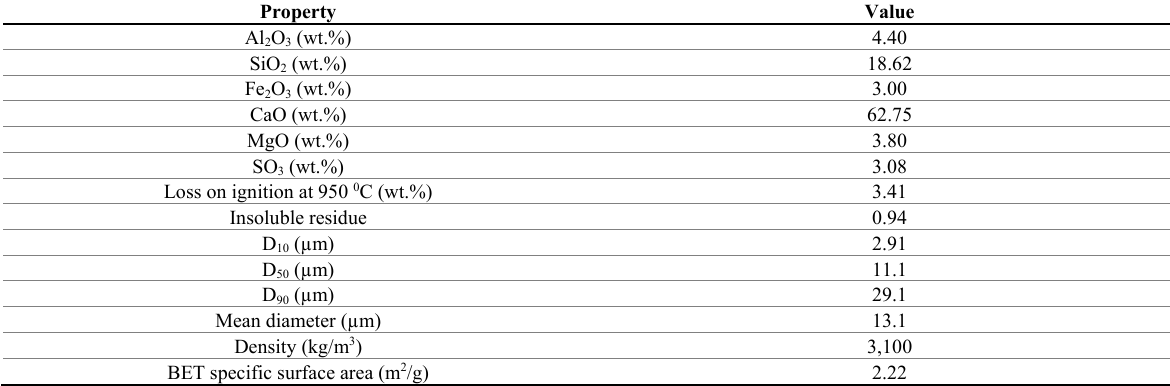
Table 1. Chemical composition determined by XRF and physical properties of the cement used.